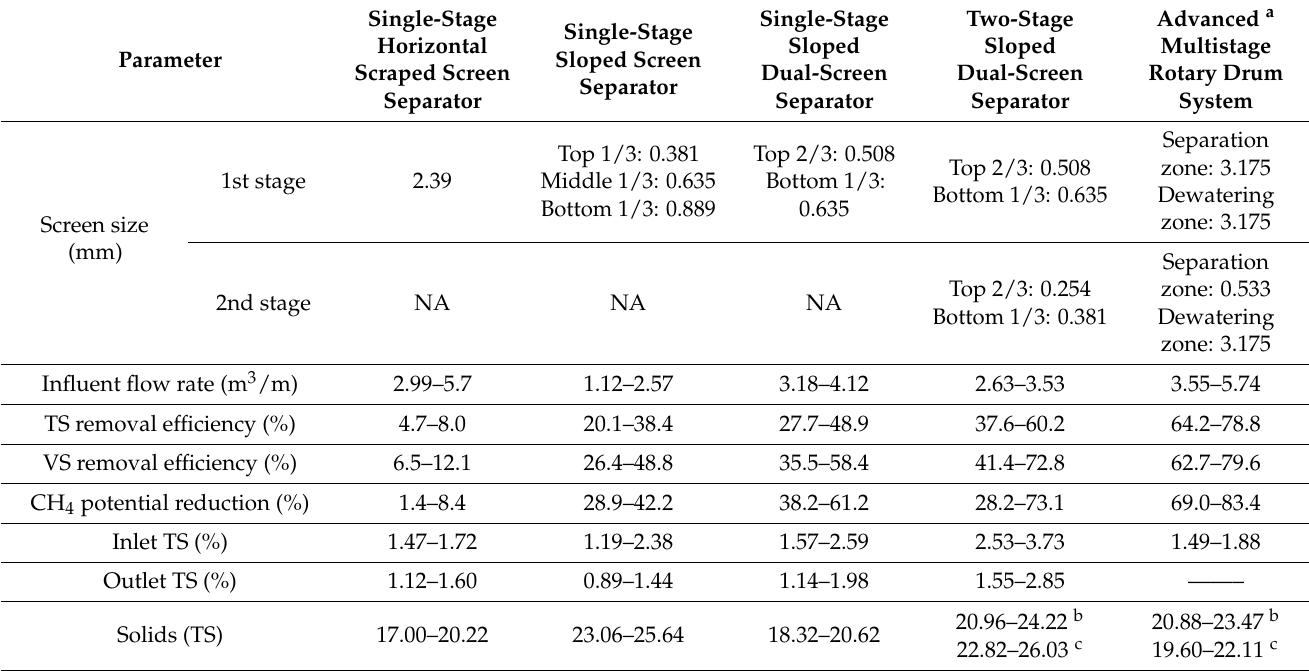
Table 2. Solid removal efficiencies and CH 4 reduction potential of some mechanical separation technologies installed at Californian dairies